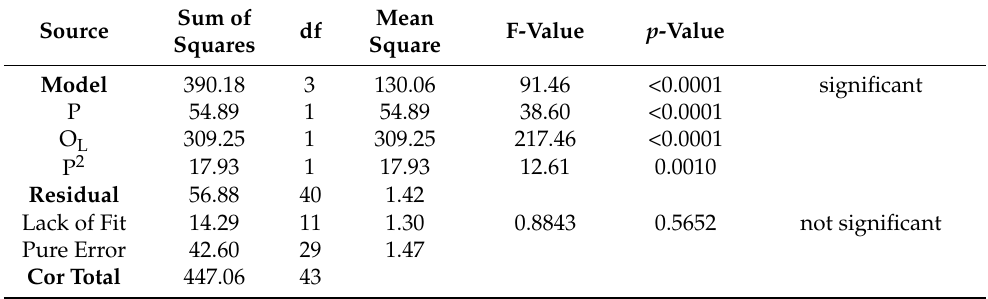
Table 9. ANOVA for RSD 1.